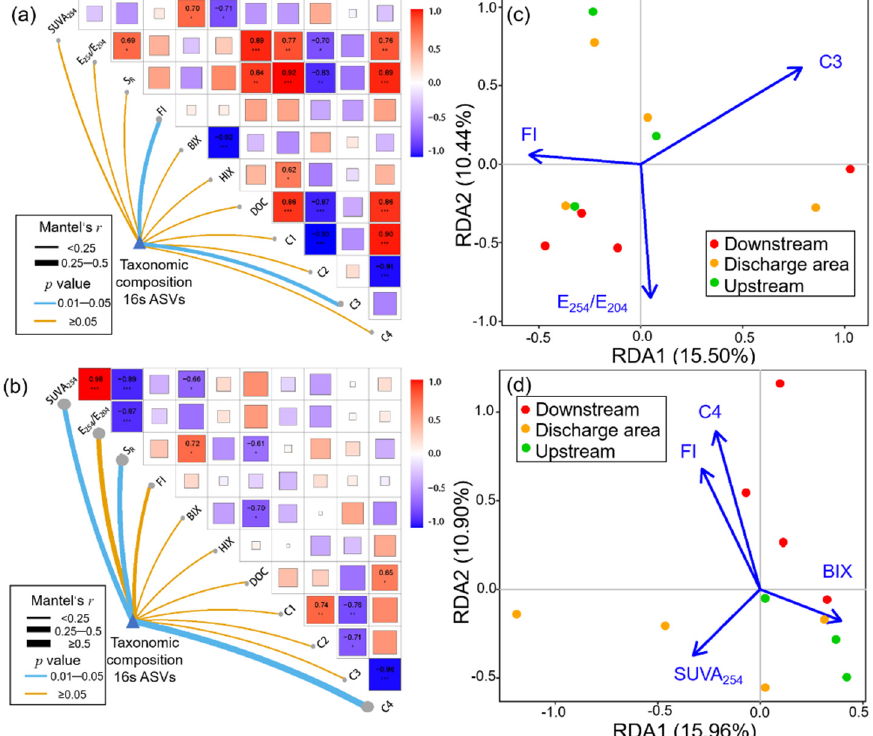
Figure 6. WSOM parameters driving the composition of bacterial communities in the effluent-receiving waterbodies. Mantel test between taxonomic community and biofilm WOSM parameters in ( a ) winter and ( c ) summer. RDA analysis based on bacterial community composition in ( b ) winter and ( d ) summer. (* p < 0.05; ** p < 0.01; *** p < 0.001).